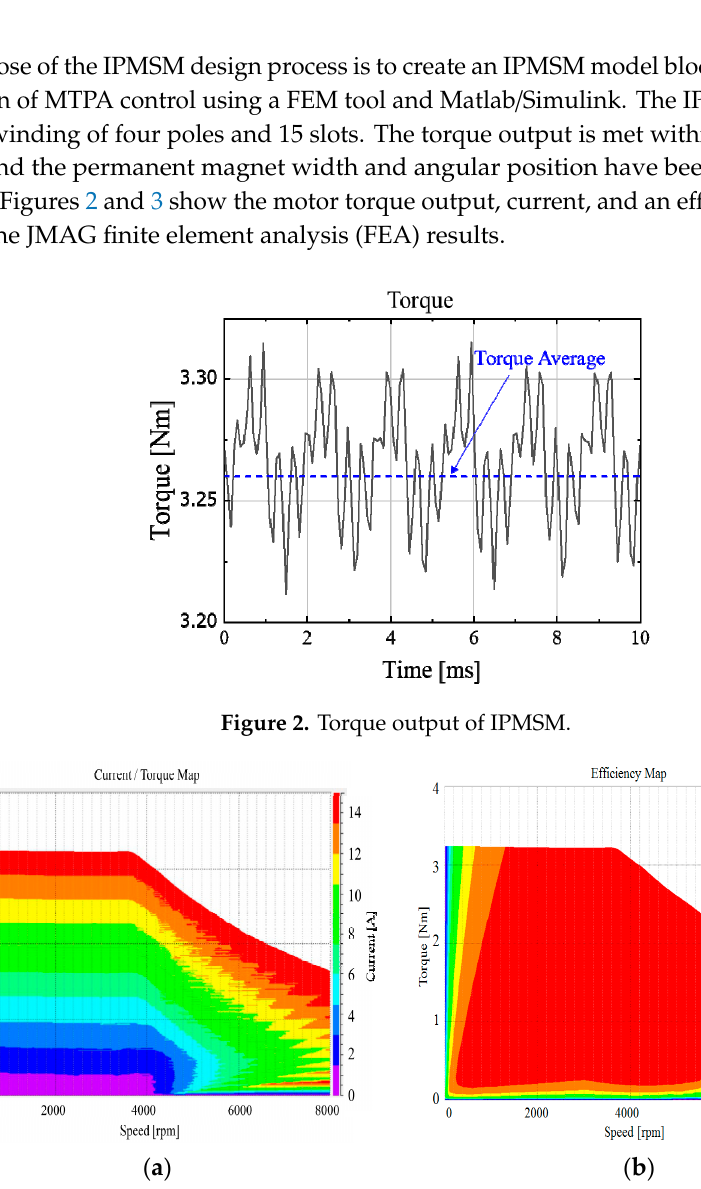
Figure 3. Torque output according to speed of IPMSM: ( a ) current map and ( b ) efficiency map.